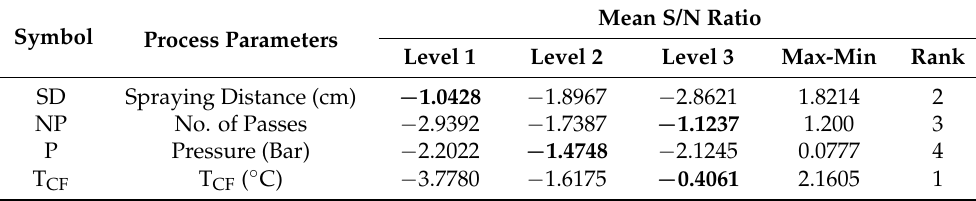
Table 5. Mean S/N ratio response for C d .